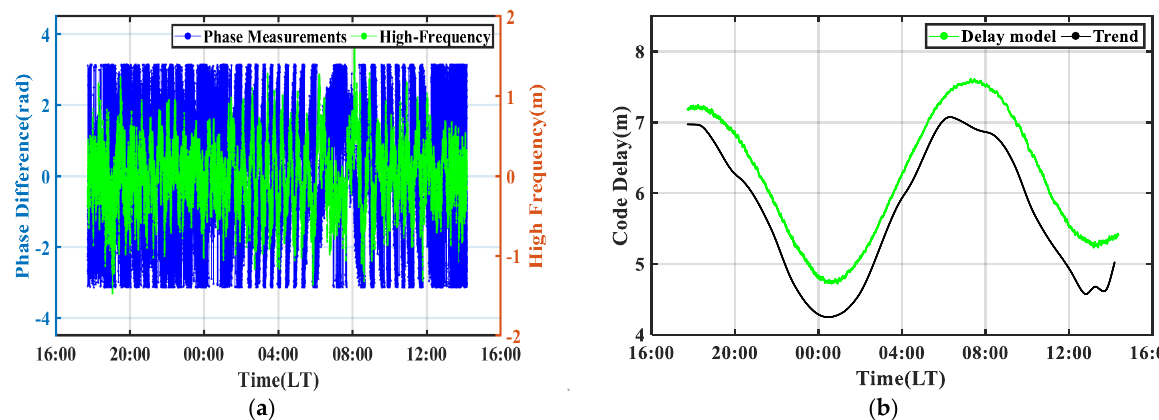
Figure 8. The results after the EMD method: ( a ) The comparison between the phase delay measurements (blue) and the high-frequency term (green); ( b ) The comparison between the trend (black) and the code delay model (green).